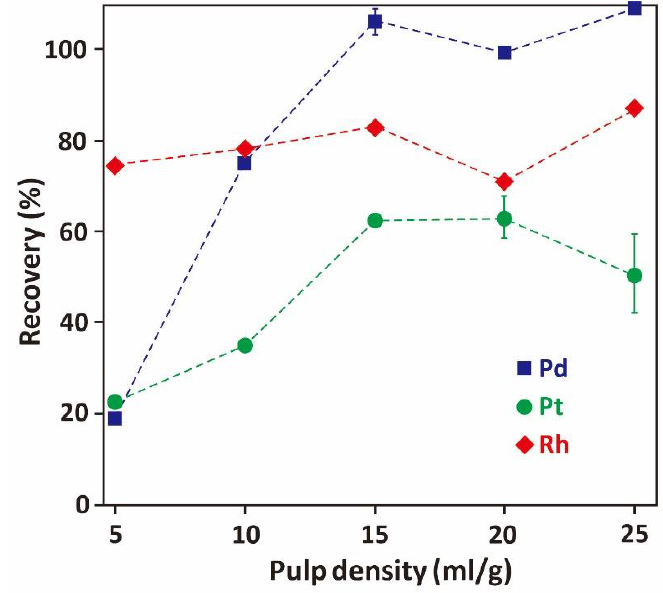
Figure 7. The e ff ect of leaching parameter pulp density on PGE Figure 7. The effect of leaching parameter pulp density on PGE recovery.